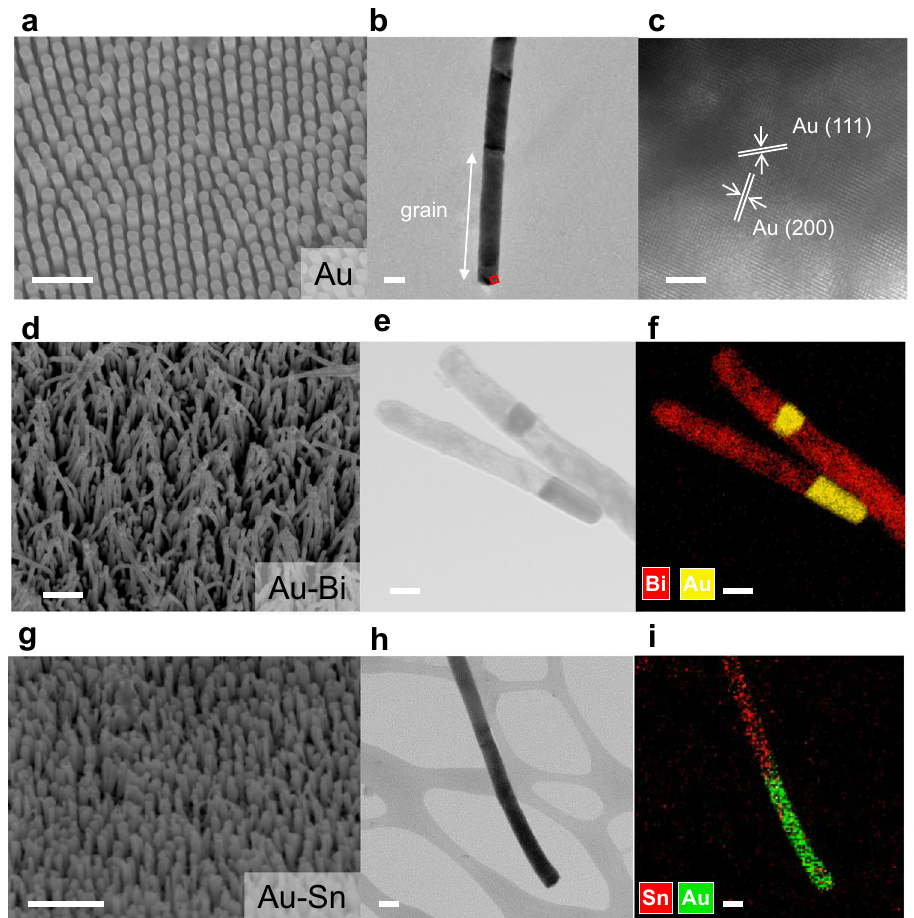
Fig. 2 SEM and TEM images of metal nanowires. a , d , g SEM images of fabricated Au nanowires, Au – Bi, and Au – Sn heterojunction nanowires. b TEM image of an Au nanowire. c The HRTEM image of the area delineated by the red square in ( b ). e , f , h , i STEM and EDS of Au – Bi and Au – Sn heterojunctions. Scale bars, 1 μ m ( a , d , g ), 100 nm ( b , e , f , h , i ), and 2 nm ( c